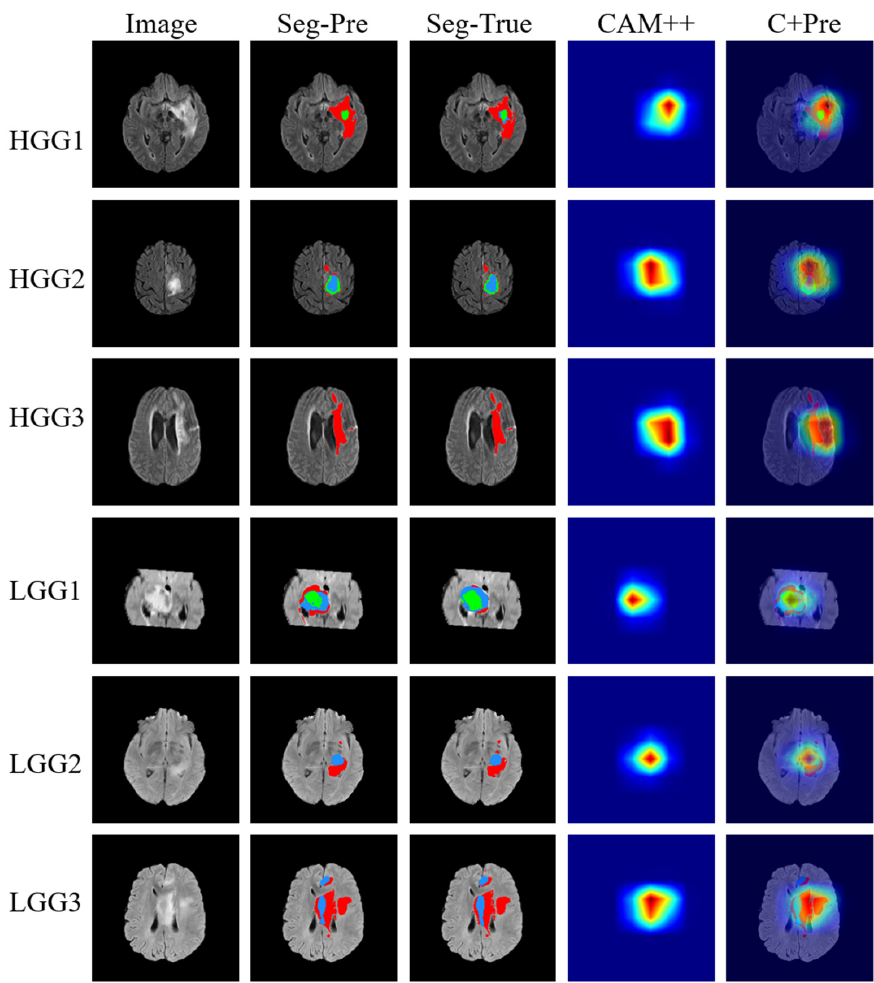
Figure 7. Comparison of brain glioma segmentation and explainability.